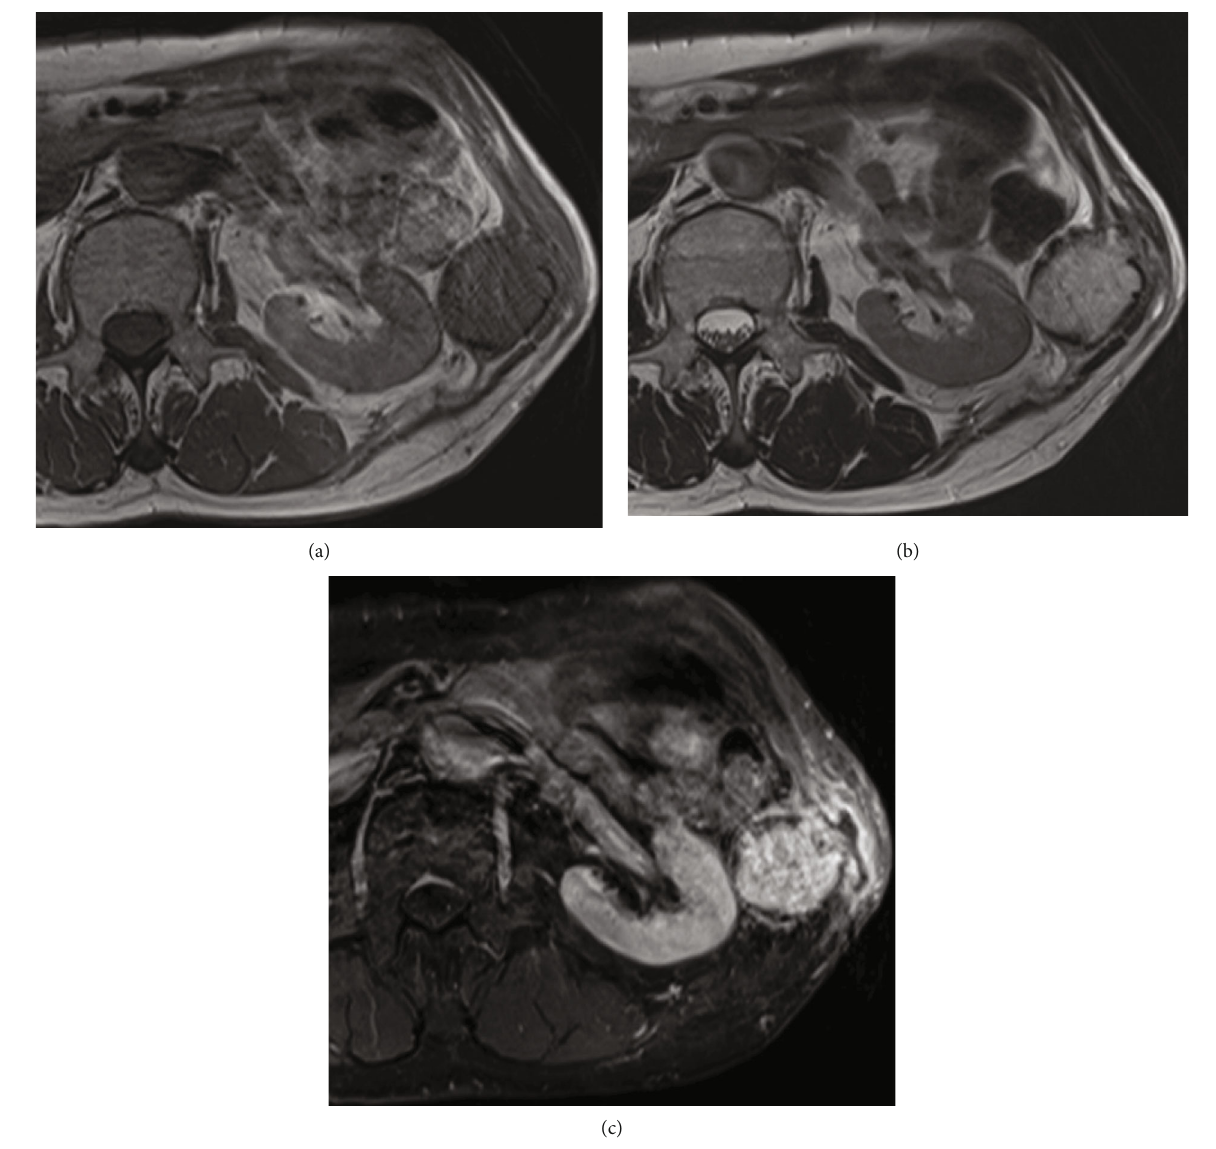
Figure 2: Magnetic resonance imaging showing the tumor in the 11th rib. (a) The mass was isointense relative to skeletal muscle on T1- weighted images. (b) The mass was hyperintense relative to skeletal muscle on T2-weighted images. (c) The mass showed enhancement on gadolinium-enhanced, fat-saturation T1-weighted